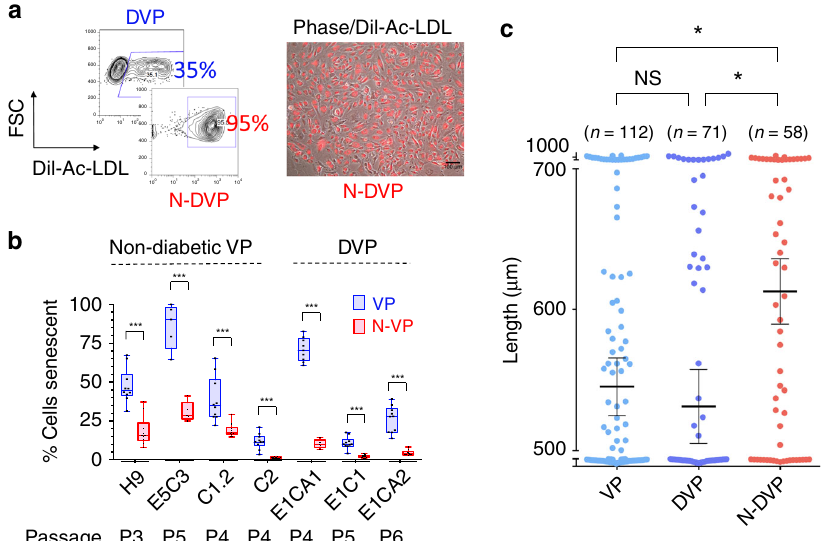
Fig. 4 Vascular functionality of primed vs. naïve VP. a Endothelial function. Shown are representative fl ow cytometry (left panel) and immuno fl uorescent Dil-acetylated-LDL (Dil-Ac-LDL) endothelial uptake assays (right panel); merged phase contrast/ Ac-Dil-LDL-labeled primed DVP vs. N-DVP cells; Scale Bar = 100 μ m. DVP cells were generated from primed vs. naïve isogenic DhiPSC line E1CA2. b Expanded (non-diabetic) VP and N-VP and (diabetic) DVP and N-DVP were quantitated for senescent cells by β -galactosidase activity colorimetric assay. Shown are independent isogenic comparisons of both non- diabetic primed VP and N-VP (i.e., generated from H9 hESC, E5C3 CB-hiPSC, C1.2, C2 fi broblast-hiPSC lines) and diabetic DVP and N-DVP (i.e., generated from E1CA1, E1CA2, E1C1 fi broblast-DhiPSC lines). Each quantitation is an independent measurement of EGM2 cultures at indicated matched passages for each VP and N-VP type. *** p < 0.001 (multiple unpaired t -tests). c Quanti fi cation of vascular tube lengths formed from in vitro Matrigel tube assays from primed non-diabetic VP (E5C3) and isogenic primed DVP vs. N-DVP (E1CA2). The number (n) of total measurements of each of the three experimental groups from 3 – 5 independent experiments per group is labeled. * p < 0.05 (unpaired t